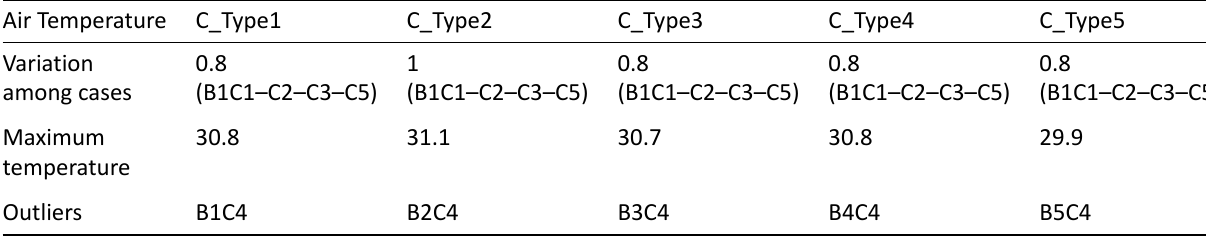
Table 4. Patterns of outdoor air temperature per context